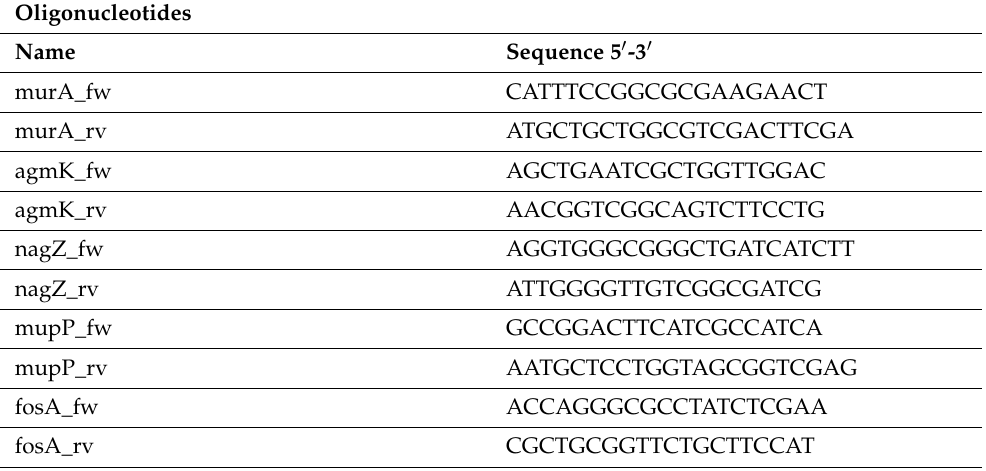
Table 2. Oligonucleotides used in this